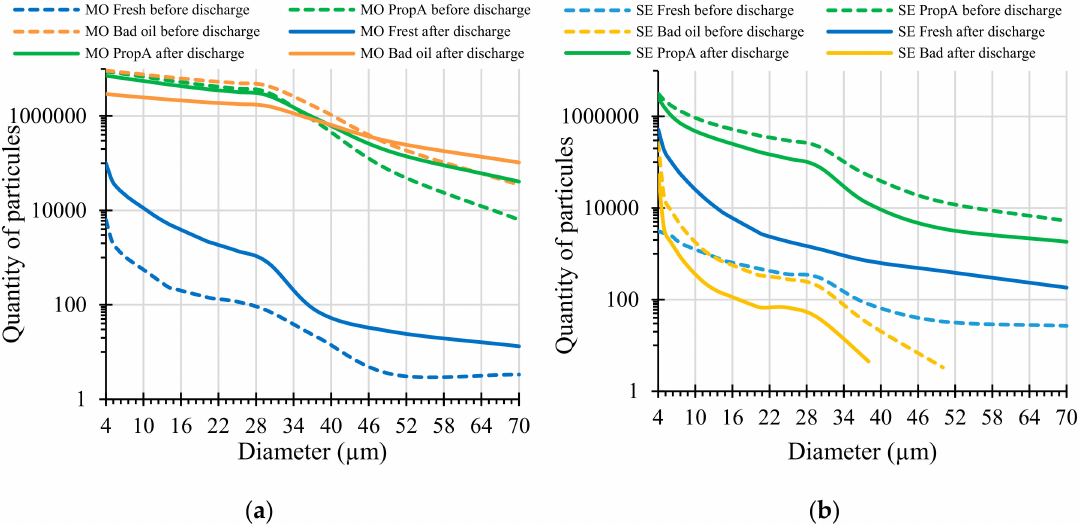
Figure 5. Change in number of particles at di ff erent aging conditions for before and after discharges: ( a ) for mineral oil; ( b ) for synthetic